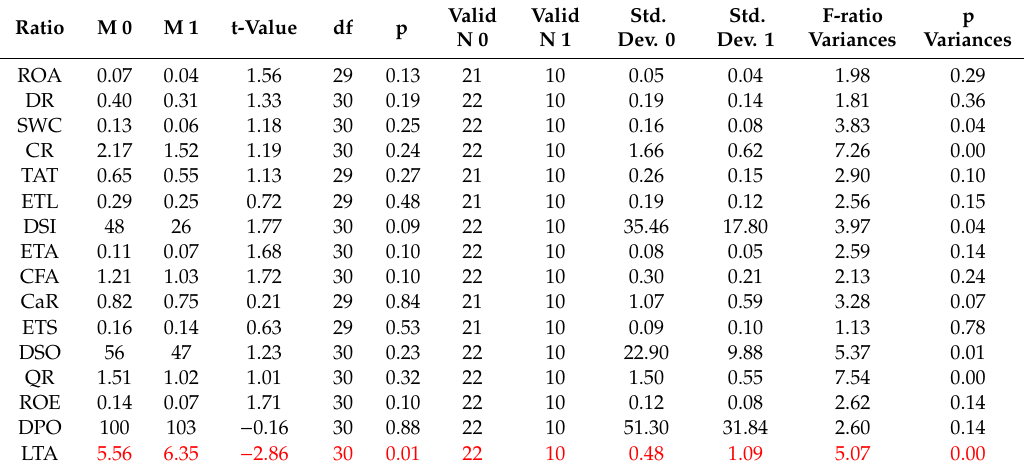
Table A9. The student’s t-test results for the chosen ratios for green (1) and red (0) companies for 2009.